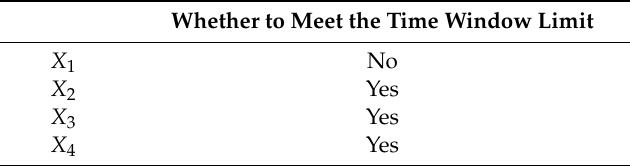
Table 12. The results of Step